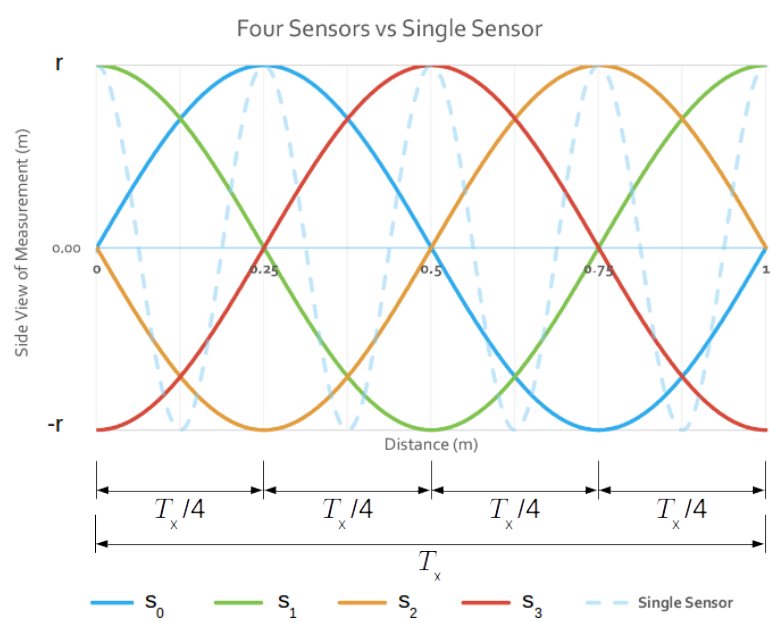
Figure 6. The behavior of four identical sensors s 0 , s 1 , s 2 , and s 3 , with phases ϕ ( k ) for each sensor s k —that is, the phase for each sensor is 0 ◦ , 90 ◦ , 180 ◦ and 270 ◦ respectively. Samples at the same head position for all sensors are out of phase and the distance between subsequent samples with the same head position is always T x /s, where s is the number of sensors. For all sensors, the distance covered while performing one full sensor revolution is T x . A 4x faster sensor is shown in blue dashed lines. As the slow sensors can sample 4 points at the same time, sampling does not happen exactly at the same points of a faster sensor, but the distance between samples are the same—for example, the floor is sampled with the same spatial distance, but not at the same